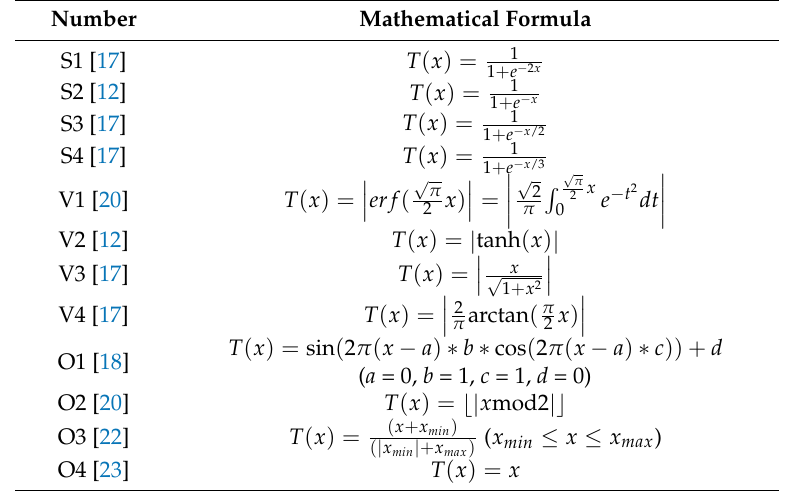
Table 1. Twelve transfer